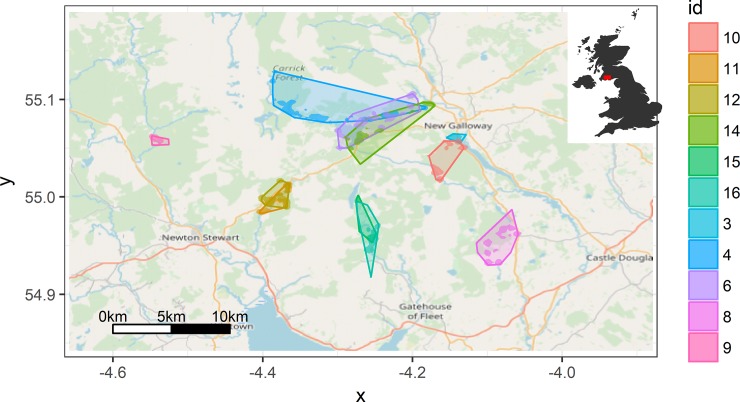
Map showing the home ranges of individual bats radiotracked in Galloway Forest Park as defined by (i) minimum convex polygons (light shaded area) and (ii) kernel density estimates (dark shaded area).